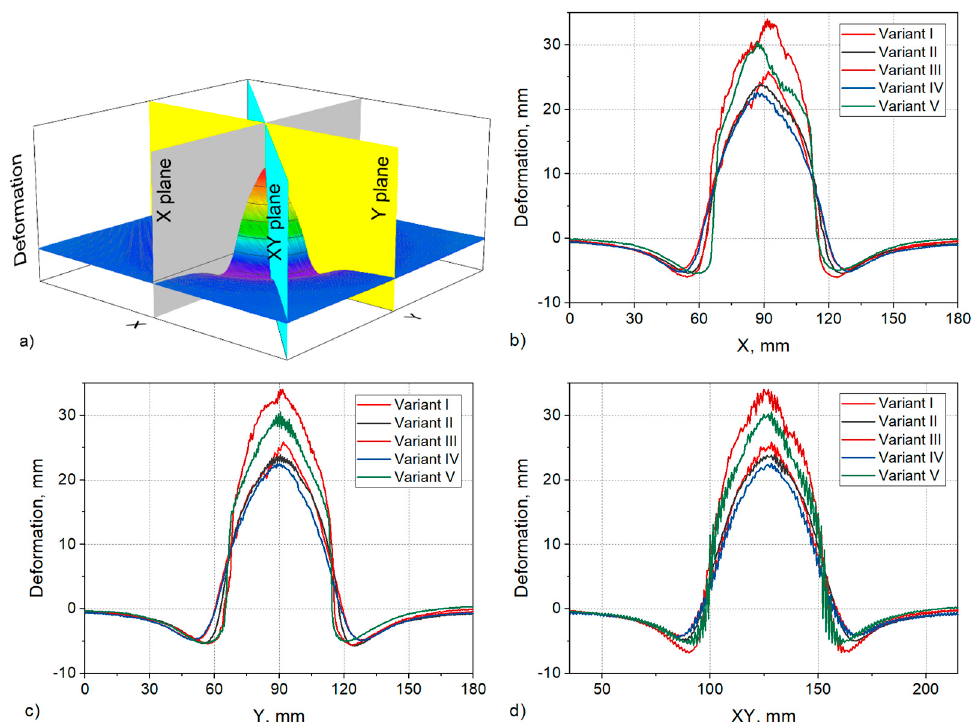
Figure 7. Cross sections of the plasticine substrate at the point of bullet impact for individual variants of ballistic packages: ( a ) diagram of the ballistic substrate division according to the planes in the X, Y and XY axes, ( b ) substrate cross sections in the X plane, ( c ) substrate cross sections in the Y plane, ( d ) substrate cross sections in the XY plane.